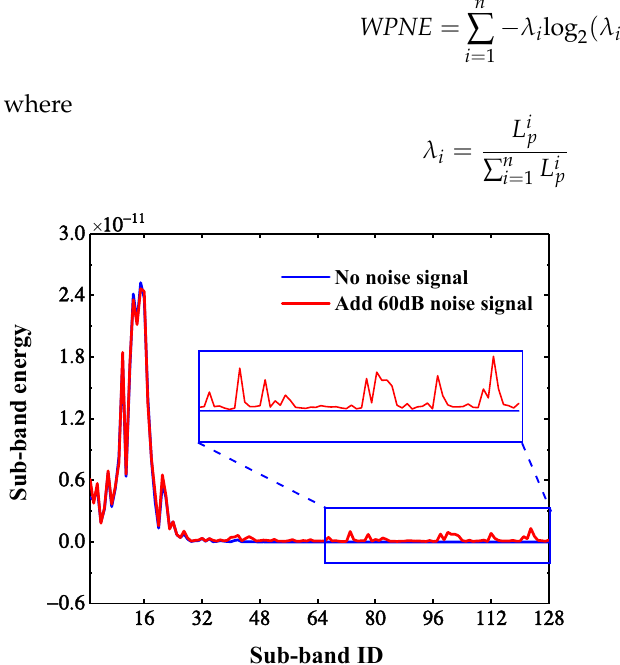
Figure 20. Sub-band energy ratio before and after adding 60 dB noise.